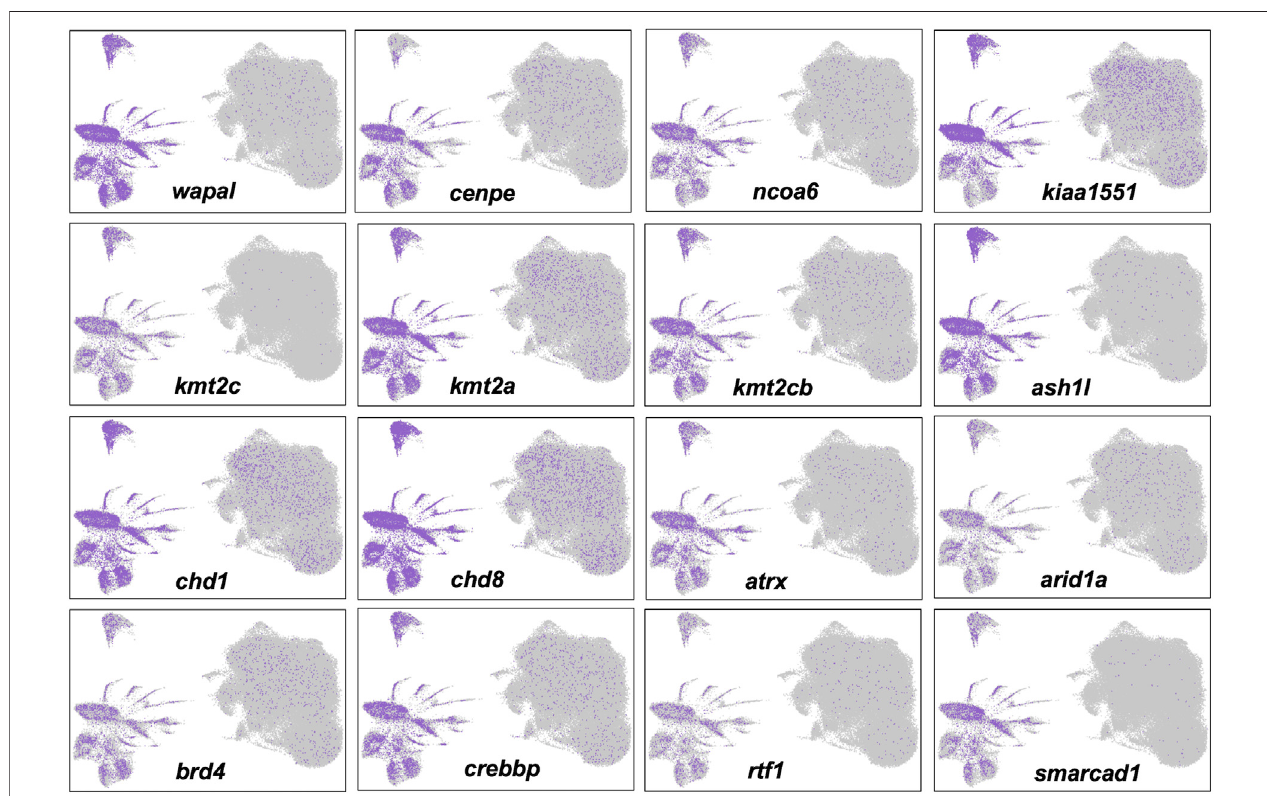
FIGURE 6 | Alternative transcriptional states identi fi ed by single nuclei RNA-Seq are associated with the differential expression of epigenetic and transcription factors.Twelvegenesthatareknowntofunctioninhistonemodi fi cation,chromatinremodeling,andtranscriptionalregulationweremorehighlyexpressedinnucleiinthe left half of the UMAP projection.